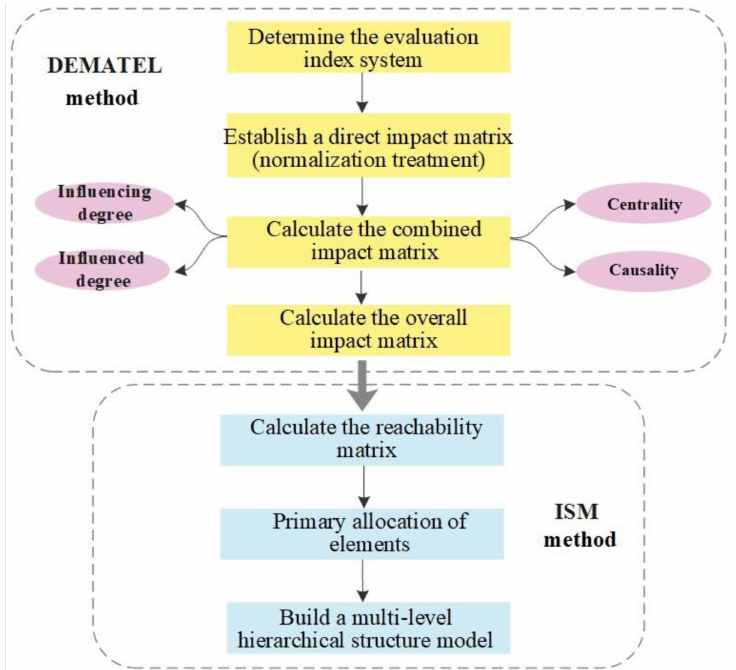
Figure 4. The DEMATEL–ISM method operation flow chart. Note: The figure is drawn with Microsoft Visio